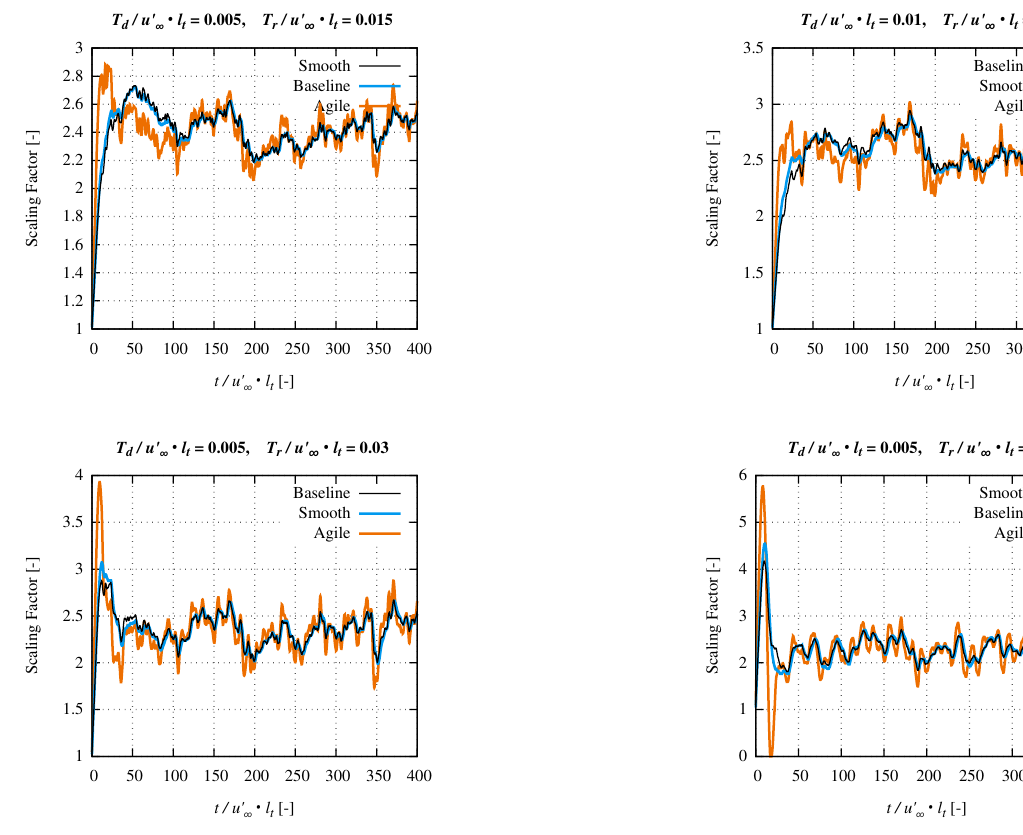
Figure 2. Evolution of the amplification factor from smooth, baseline and agile controller coefficient settings for several pairs of delay and rise time. Table 1. Tuning constants for the controller coefficient setting.